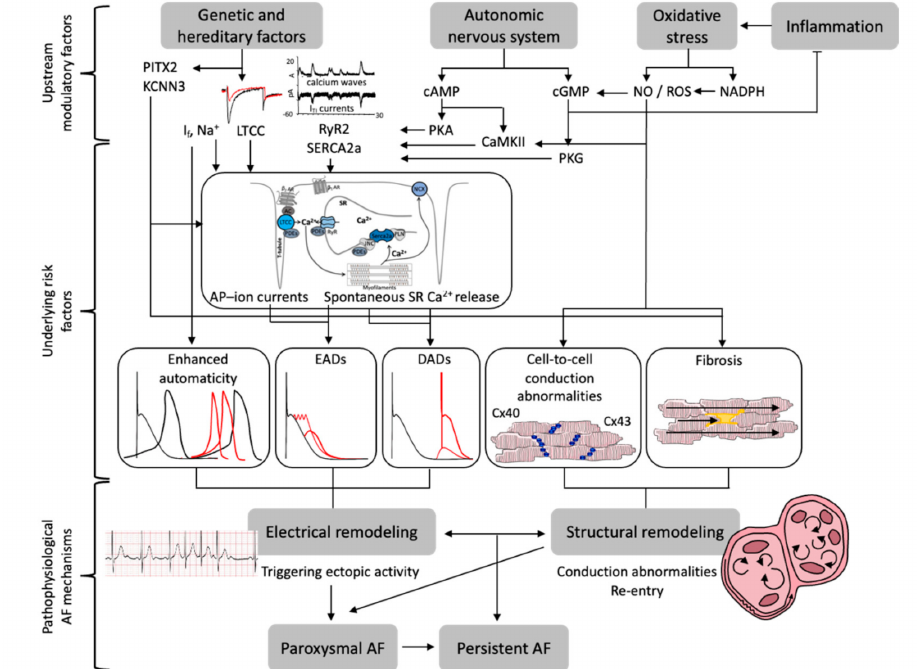
Figure 1. Pathophysiological mechanisms underlying initiation and maintenance of atrial fibrillation (AF). Summary of upstream modulatory factors, underlying risk factors and pathophysiological AF-associated mechanisms. Abbreviations: PITX2 = paired-like homeodomain transcription factor 2, KCNN3 = Potassium Ca 2+ -Activated Channel, I f = funny current, LTCC = L-type Ca 2+ channel, RyR2 = ryanodine receptor 2, SERCA2a = SR Ca 2+ ATPase, cAMP = 3 (cid:48) ,5 (cid:48) -cyclic adenosine monophos- phate, PKA and PKG = protein kinase A and G, CaMKII = Ca 2+ -calmodulin dependent protein- kinase type-II, NO = nitric oxide, ROS = reactive oxygen species, NADPH (Nicotinamide ade- nine dinucleotide phosphate), cGMP = cyclic guanosine monophosphate, AP = action potential, SR = sarcoplasmic reticulum, EADs/DADs = early/delayed afterdepolarizations, Cx40/43 = con- nexin 40/43, AF = atrial